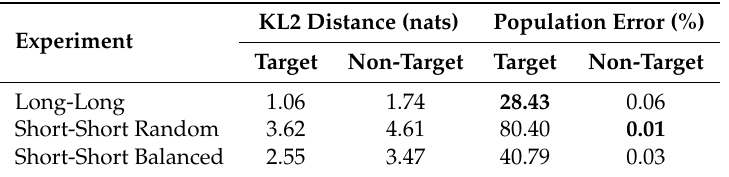
Table 3. Kullback Leibler (KL) distance and Error (%) for both target and non-target trials in experiments Long-Long, Short Short Random and Short-Short Balanced. Error estimated at National Institute of Standards and Technology (NIST) operating